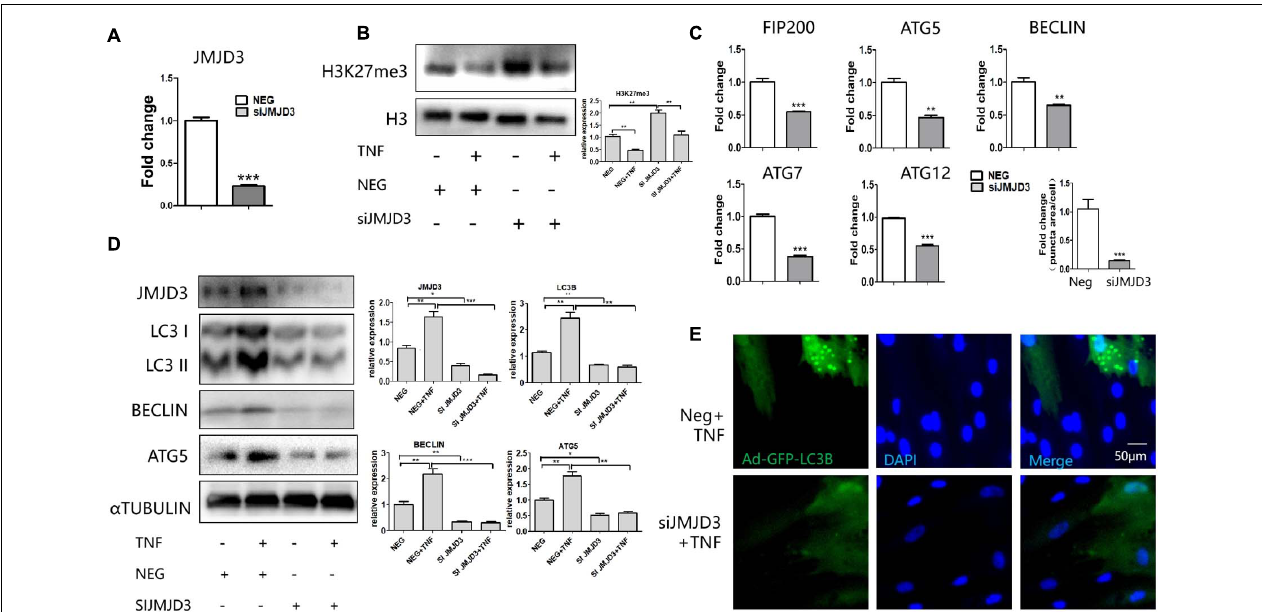
FIGURE 4 | JMJD3 siRNA regulated the decrease of autophagy related genes. (A) QPCR analysis of JMJD3 level after JMJD3 siRNA transfection. (B) Western blot analysis of H3K27me3 level after the treatment of JMJD3 siRNA. The relative quantification was on the right. (C,D) QPCR (C) and western blot (D) analysis of autophagy related genes in response to JMJD3 siRNA. The relative quantification was on the right. (E) GFP-LC3B-expressing HDPCs cells were treated with JMJD3 siRNA for 24 h followed by TNF α or PBS treatment. The relative quantification was on the upper side. ** P < 0.01, *** P < 0.001.